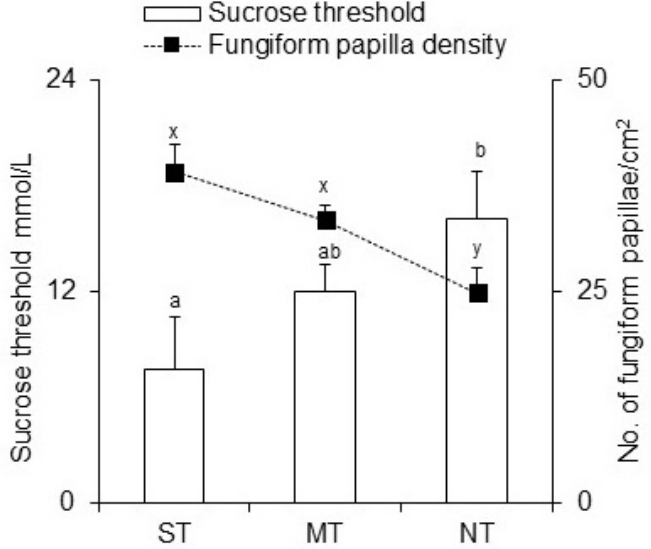
Figure 5. Sucrose threshold (mmol/L) and density of fungiform papillae (No./cm2) according to PROP taster status. All values are means ( ± SEM). n = 107. ST, super tasters; MT, medium tasters; and NT, non-tasters. Different letters indicate significant differences (a, b, and c are used to denote differences in sucrose threshold ( p = 0.021, LSD test subsequent one-way MANOVA), x and y are used to denote differences in fungiform papillae density ( p < 0.014 Duncan’s test, subsequent one-way MANOVA).